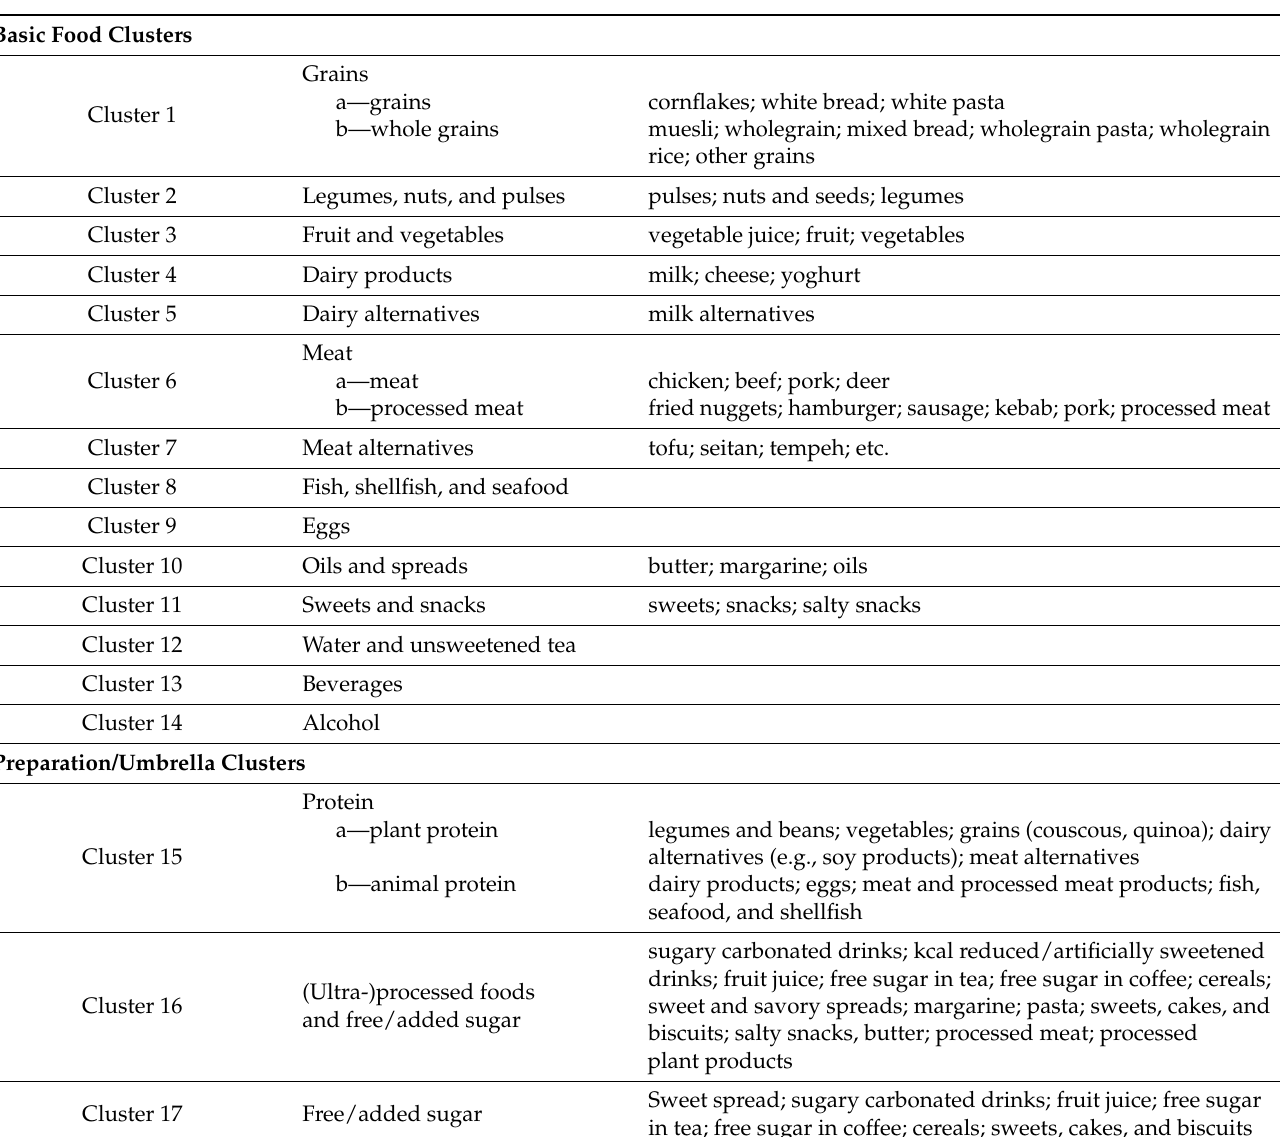
Table 1. Modeling of the Clusters for Food Frequency (Basic Nutrition and Consumption Cluster 1 to 14; Umbrella Cluster for Preparation Cluster 15 to